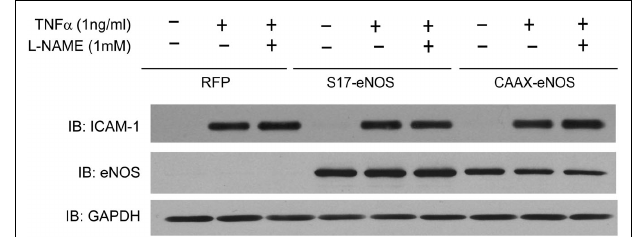
FIGURE 2 | “Endothelial nitric oxide synthase knockdown” HAECs were transduced with adenovirus (MOI of 20) encoding either RFP (control), S17-eNOS (Golgi targeted), or CAAX–eNOS (PM targeted). Twenty-four hours later, cells were treated with L-NAME (1mM) for 30min, andTNF α (1ng/ml) was added for an additional 24h. Cell lysates were immunoblotted with anti-ICAM-1, anti-eNOS, and anti-GAPDH